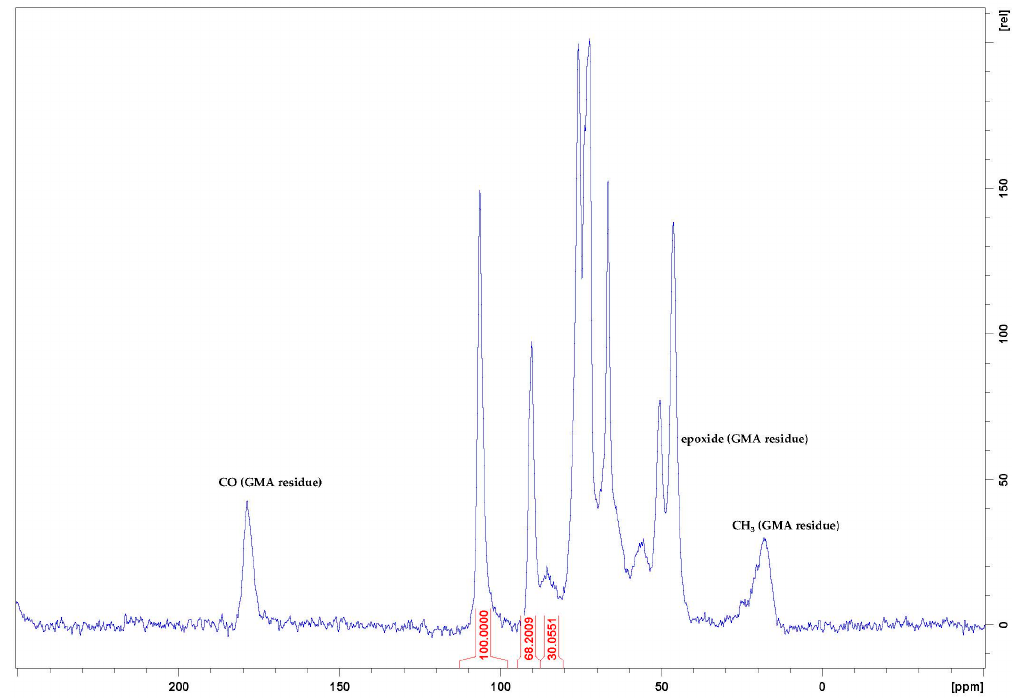
Figure 9. CP-MAS 13 C NMR of BNC-GMA MS = 0.68 -integration: cellulose signals plus GMA signals.